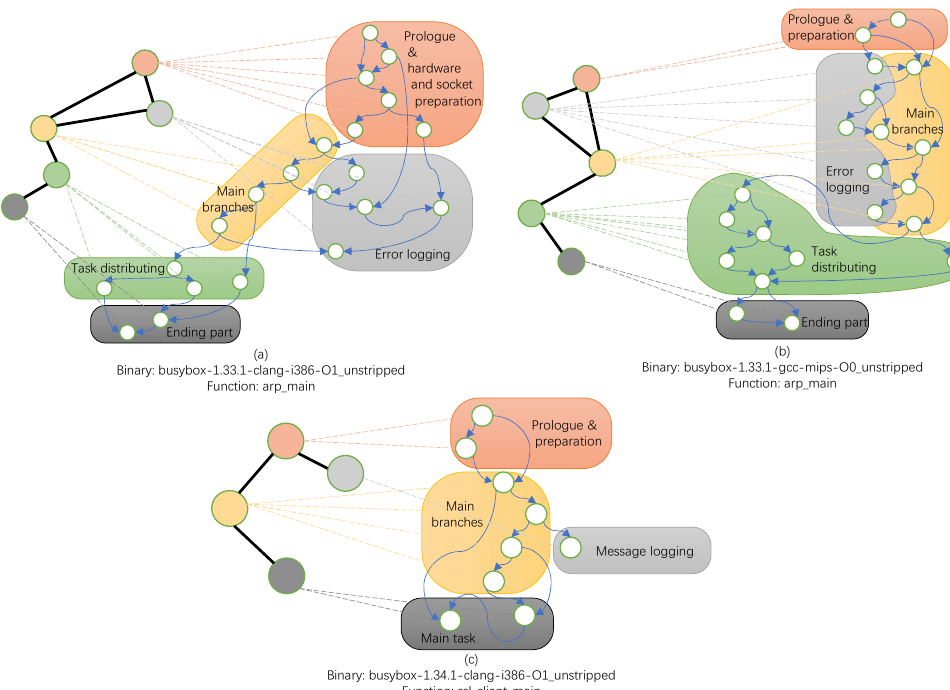
Figure 1. Functions with functional module